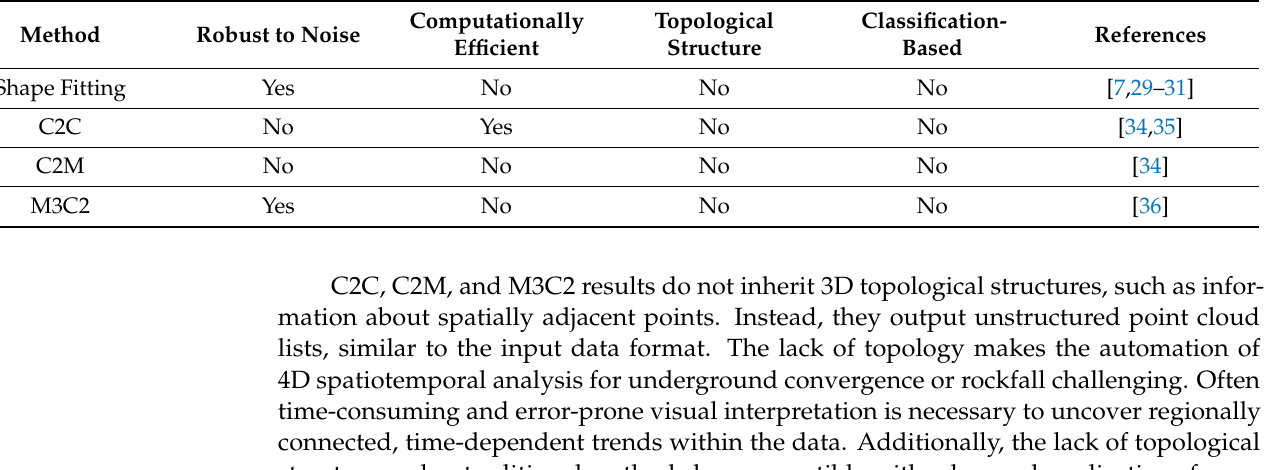
Table 1. Properties of traditional change detection